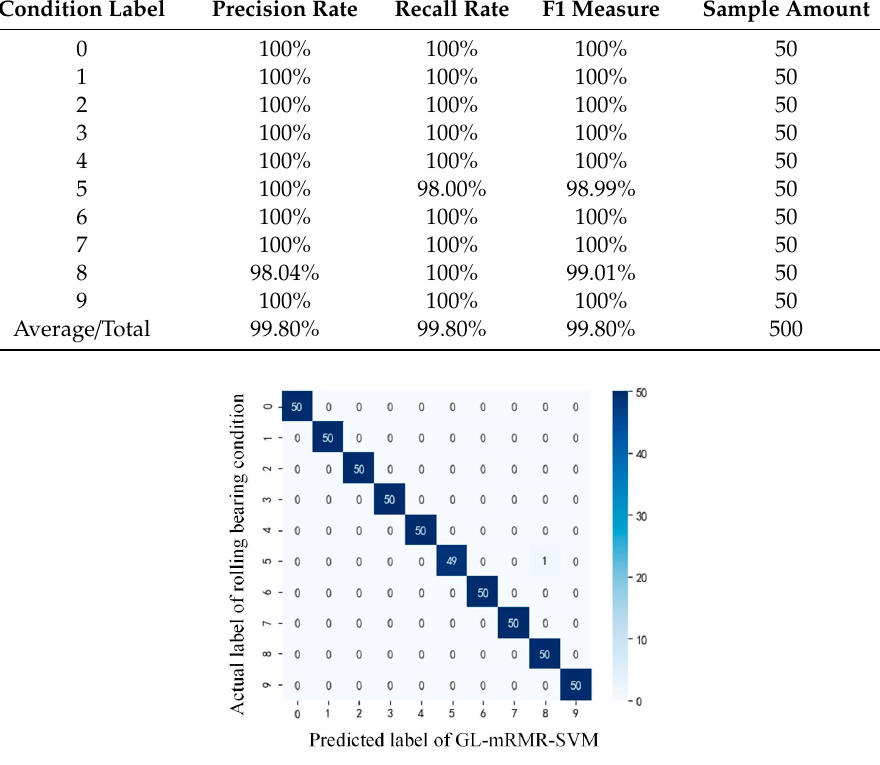
Table 4. Test results of the proposed GL-mRMR-SVM model.